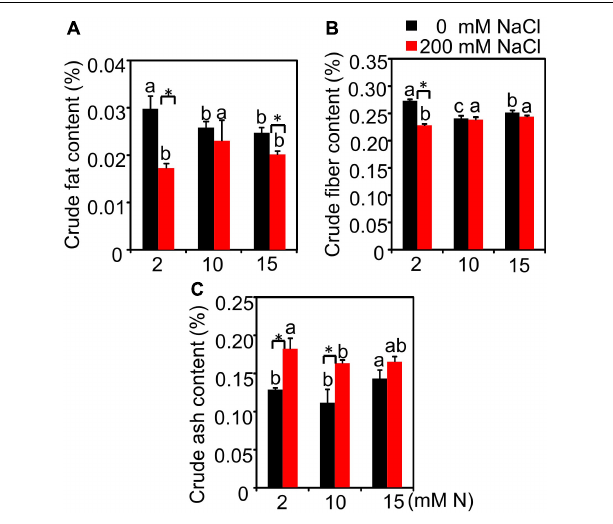
FIGURE 7 | The quality-related traits of bermudagrass under different treatments. Crude fat content (A) , crude fiber content (B) , and crude ash content (C) in the leaves of plants grown with different nitrogen concentrations (2, 10, and 15 mM N) exposed to different NaCl levels (0 and 200 mM NaCl), respectively. Different letters above the columns indicate statistically significant differences at P < 0.05 under different N levels with the same NaCl level by Tukey’s test. ∗ Shows significant differences ( P < 0.05) under 200 mM NaCl treatment and 0 mM NaCl condition with the same N level by Tukey’s